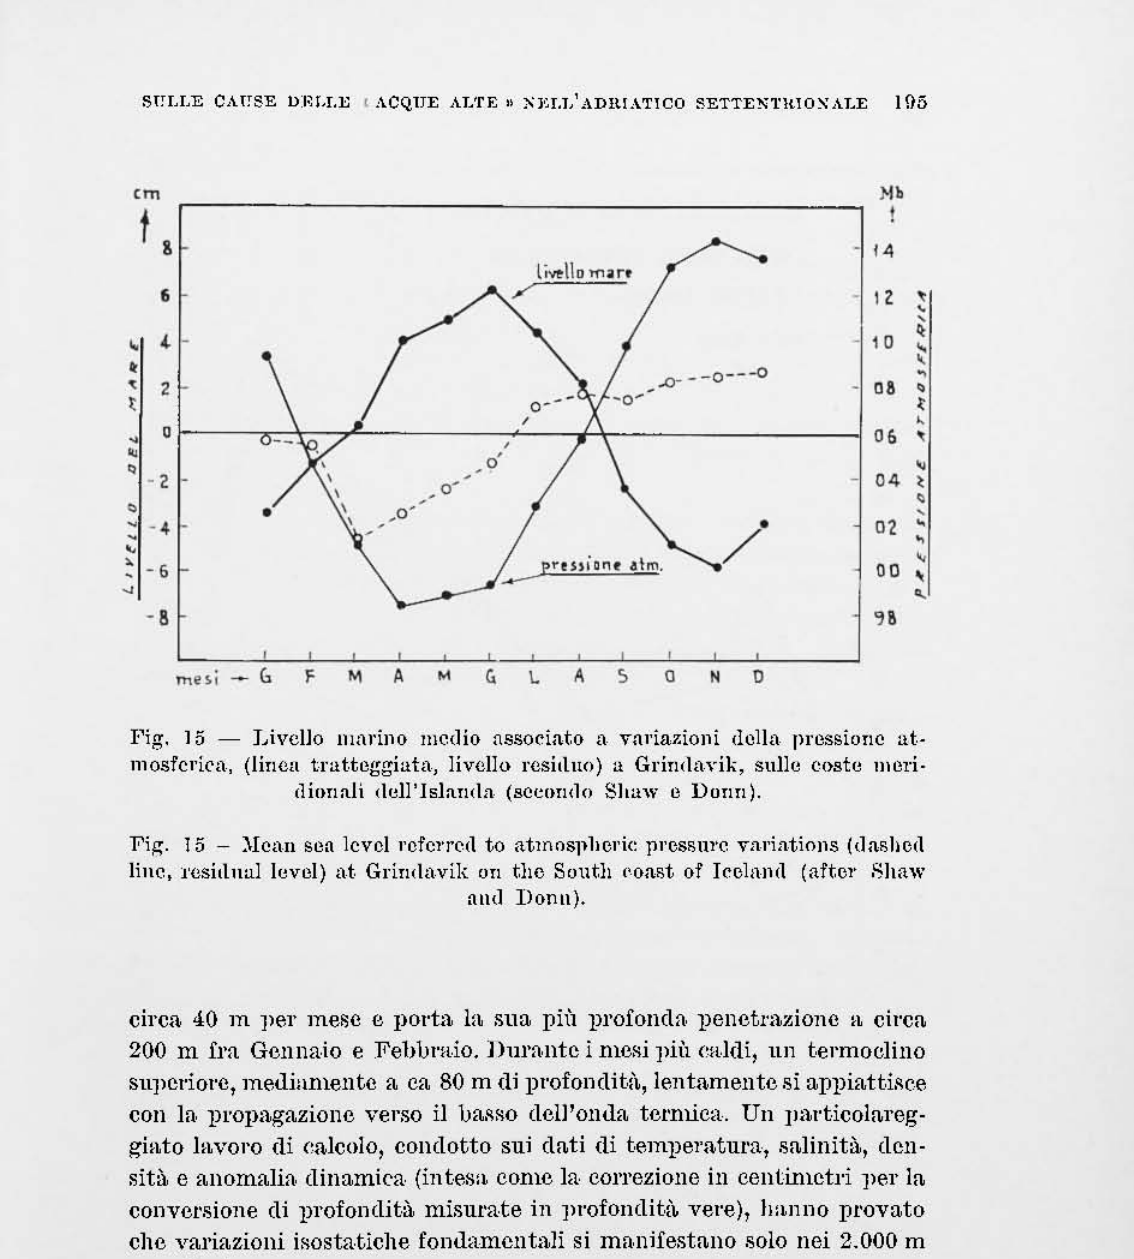
Fig. 15 - Livello marino medio associato a variazioni della pressione at mosfel'ira, (linea tratteggiata, livello resitluo) a Griw!avik, sulle e(}ste meri dionali (lell'Islawla (secolulo Slmw e Donn). Fig'. 15 - )'Iean sen levell'efel'l'ed to atmospllCl'k pl'eSSUl'e val'iations (dashed line, l'esitlnal level) at Griwlavik on the South ('·oast of Icclnnd (aftcl' Shaw nnd